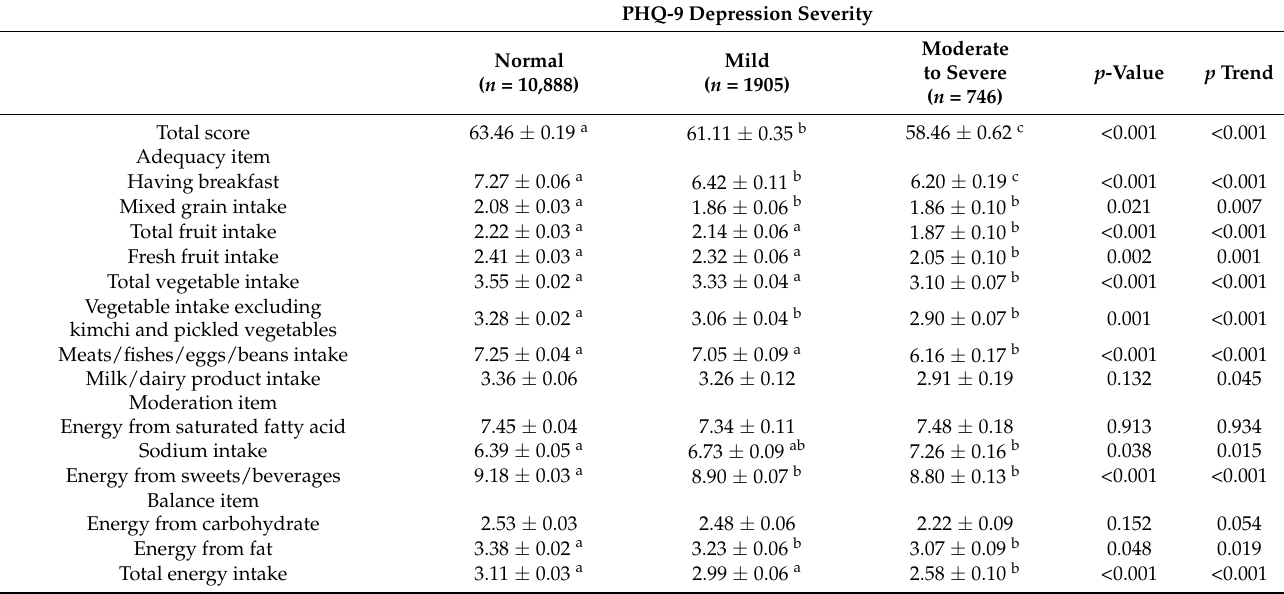
Table 2. Diet quality was measured by the Korean healthy eating index of subjects according to depression